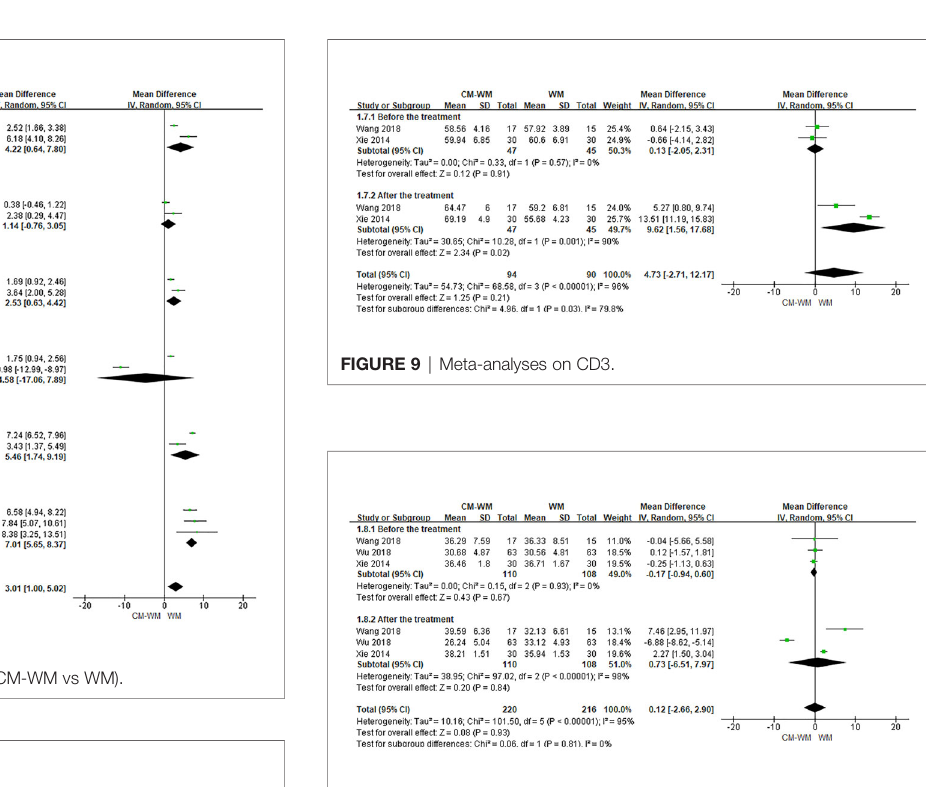
FIGURE 10 | Meta-analyses on